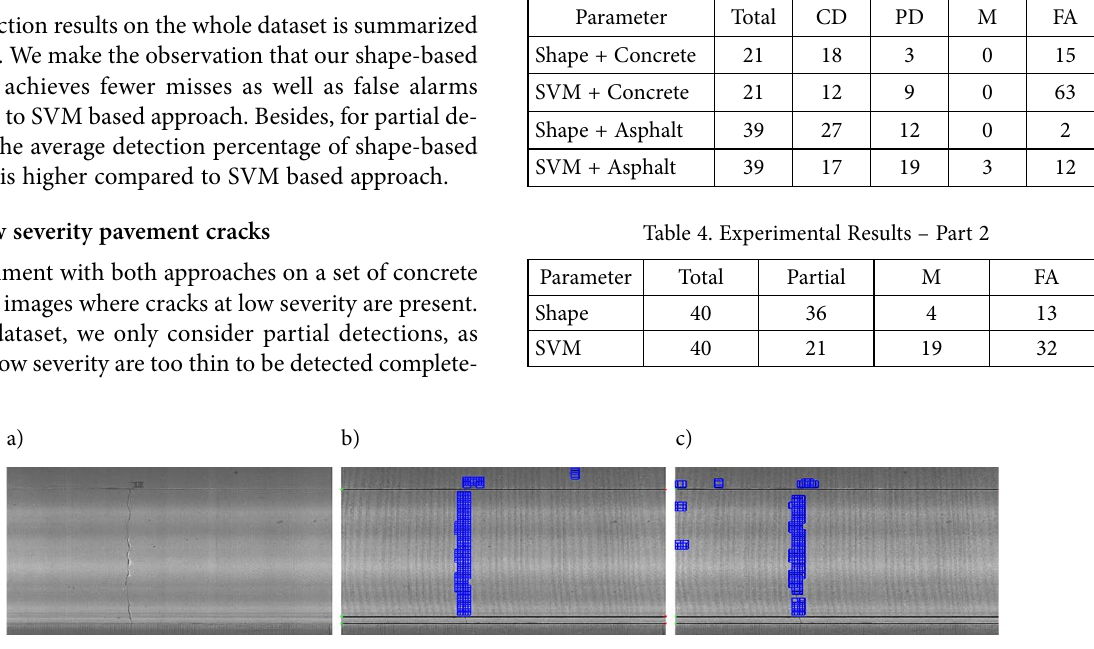
Figure 12. An example of high severity PCC pavement crack detection: a – actual image; b – shape-based crack detection; c – SVM based crack detection